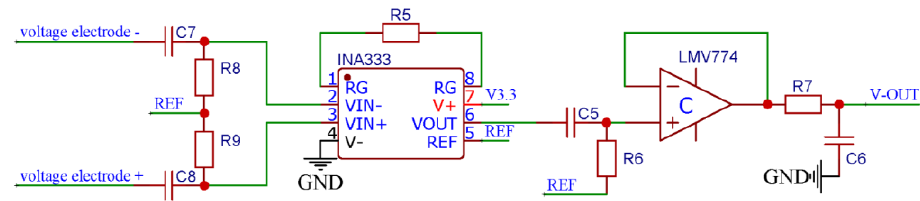
Figure 13. The block scheme of a differential amplifier circuit for the inner electrode signal. In addition, the current signal is converted into a voltage signal using a capacitor to measure the liquid current, as presented in Figure 14. At this time, the potential at the negative input terminal (pin 2) of operational amplifier A is consistent with the loop current change. Assume that the liquid to be tested is an unknown resistance RK, which is connected in series with the matching resistor RM. Moreover, assume that a negative feedback amplifier resistor RF is used to amplify the potential of pin 2. The RF resistance value should be set in a way that the current signal after conversion and amplification is not distorted.